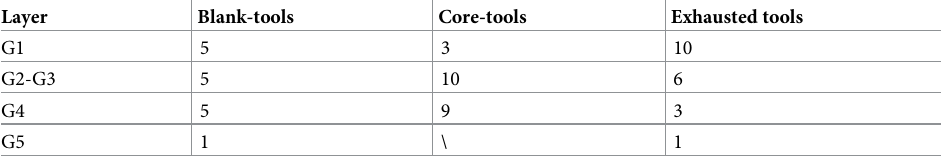
Table 11. Distribution of Keilmesser’s three different productional operational schemes for archaeological